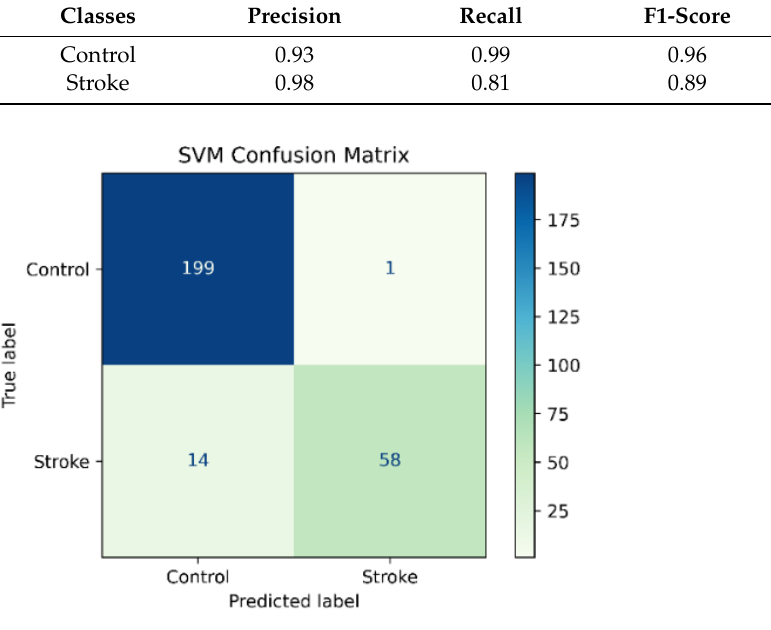
Figure 4. Support Vector Machine Confusion Matrix.